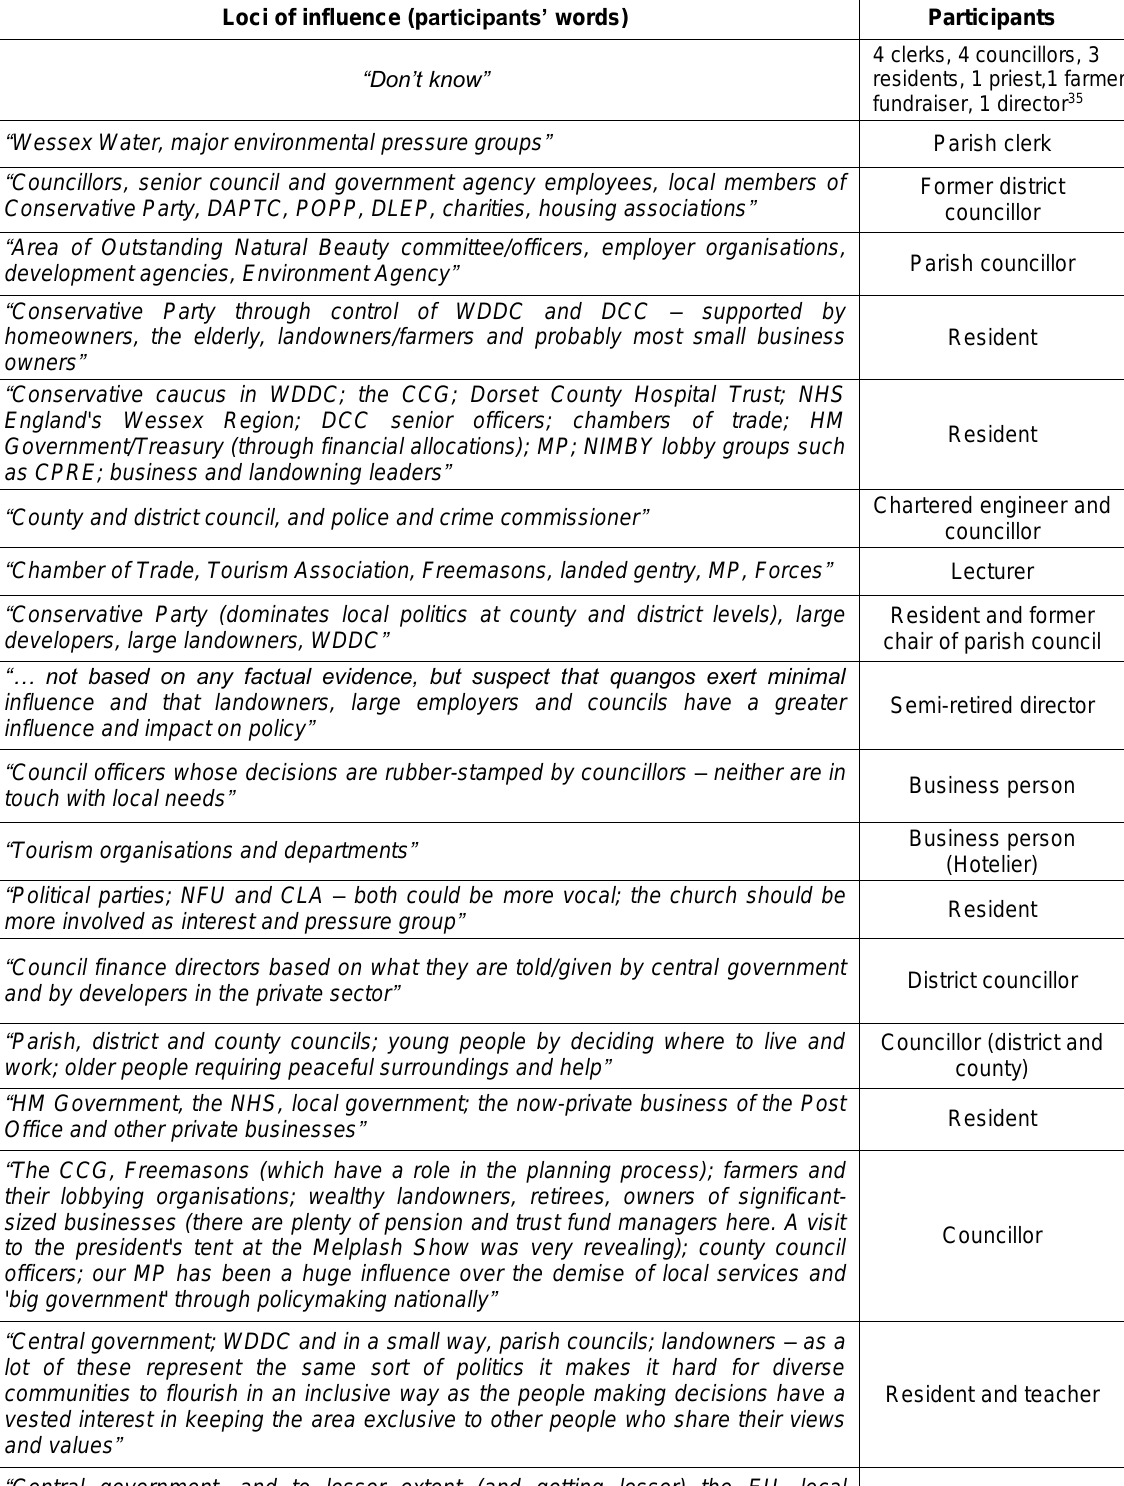
Table 5: Participants’ beliefs as to the loci of influence in West Dorset Loci of influence (participants’